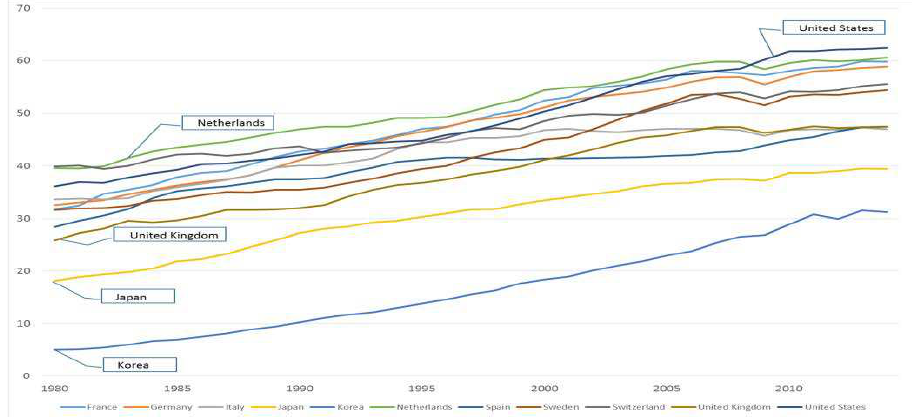
Fig. 2. Labor productivity